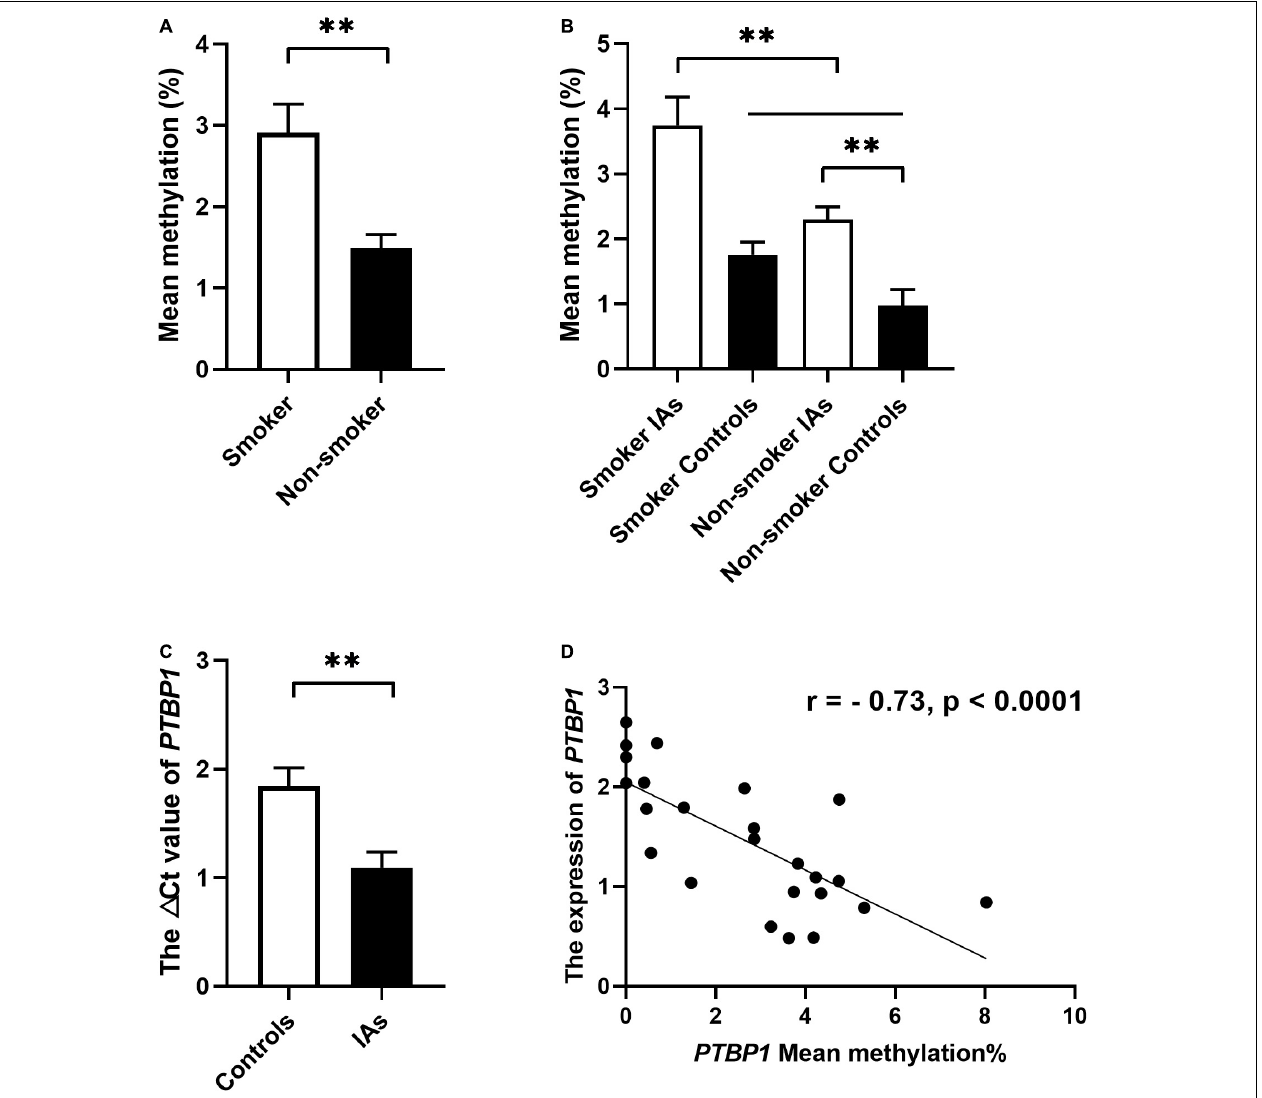
FIGURE 3 | The relationship between PTBP1 promoter DNA methylation, smoking, and gene expression in the individuals. (A) PTBP1 DNA methylation was much higher in smokers than in non-smokers. (B) PTBP1 DNA methylation was much higher in smoker IAs than other groups. (C) PTBP1 mRNA expression was much lower in IAs than in healthy controls. (D) The PTBP1 expression was significantly associated with DNA methylation in all individuals. ** p <